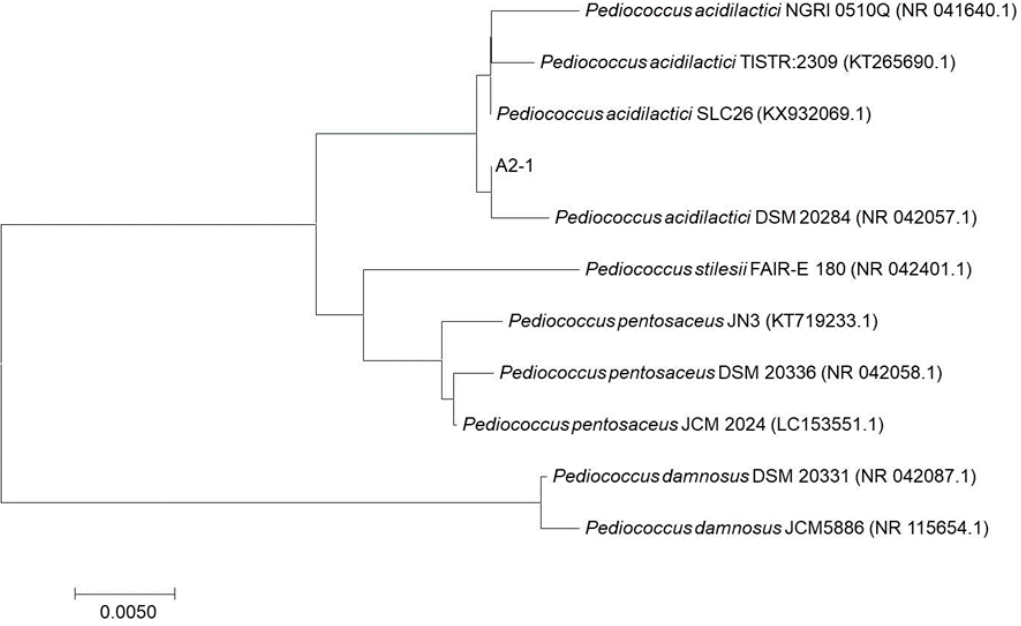
Figure 2. Phylogenetic relationship of lactic acid bacteria A1-2 isolated from aguamiel. Species are inferred by neighbor-joining analysis of the 16S rRNA gene based on evolutionary distances calculated using the Kimura two-parameter model. Numbers in parentheses are accession numbers of published sequences. Table 4. Identification of lactic acid bacteria isolates by 16S rRNA sequences.